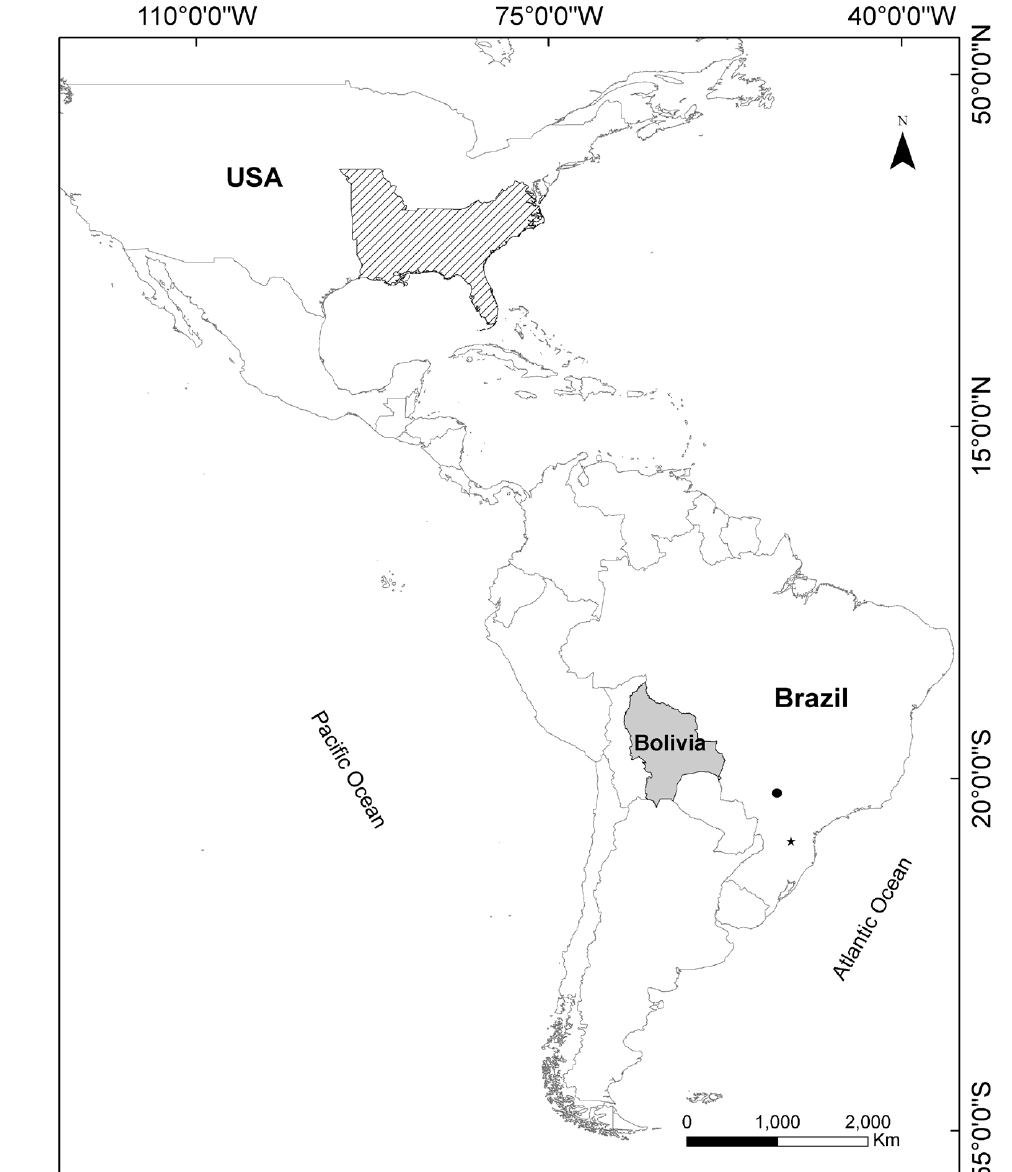
Figure 2. Distribution of Sida gracilipes (star) and Sida elliottii var. elliottii (black dots) in Brazil and the current distribution of S. elliottii var. elliottii (parallel lines) and S. gracilipes (gray). Datum used